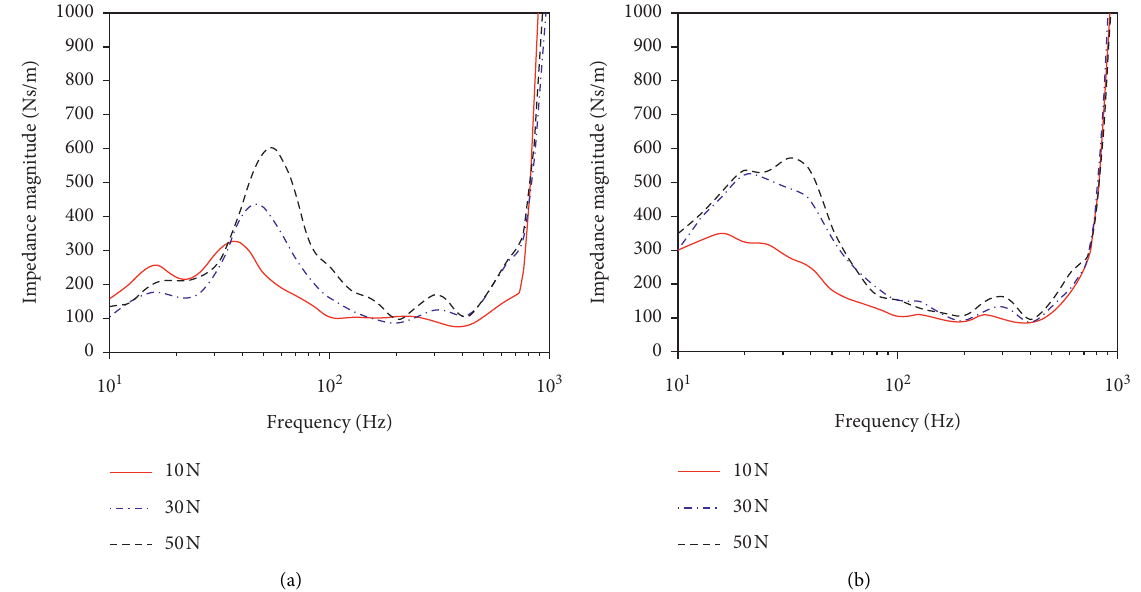
Figure 9: Amplitude of mechanical impedance of the hand-arm system under different grip forces (5m/s 2 vibration magnitude and 30N push force). (a) 90 ° elbow angle. (b) 180 ° elbow